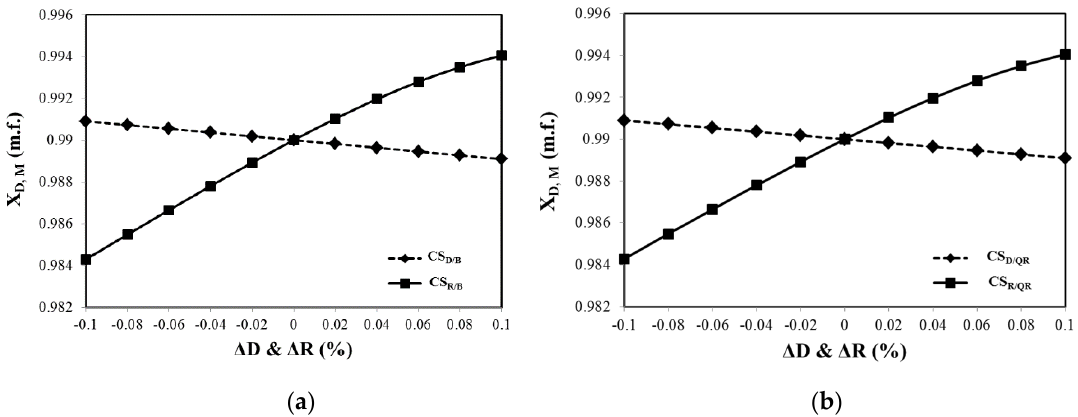
Figure 9. Static operation analysis of the Kaibel distillation column : (a) CS D/B and CS R/B structures; (b) CS D/QR and CS R/QR structures.